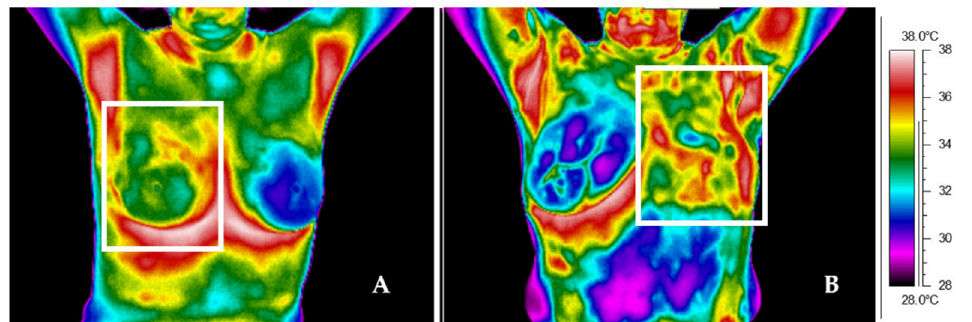
Figure 2. Thermal image of representative patient after surgery ( A ) and mastectomy ( B ) taken over 1 year and up to 5 years after the end of radiotherapy treatment.